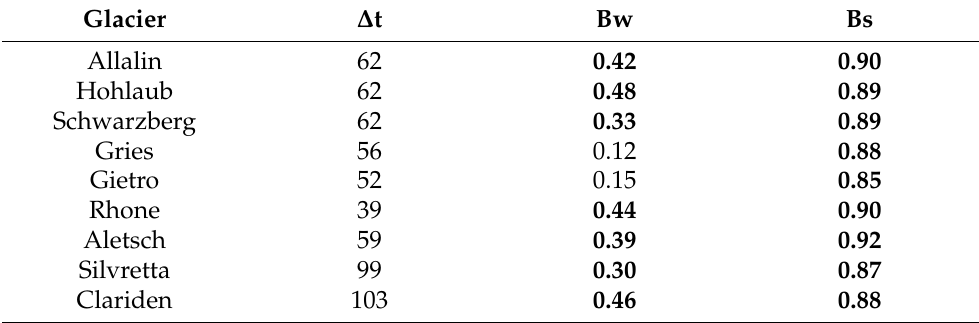
Table 4. Correlation coefficients of Ba versus Bw and Bs. Values in bold are significant at p < 0.01. Glacier ∆ t Bw Bs Allalin